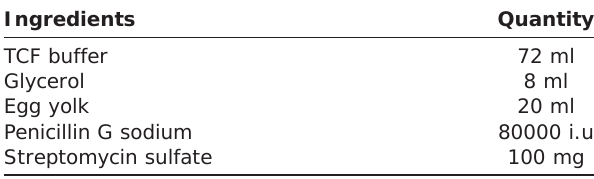
Table-2: Composition of TCF extender.